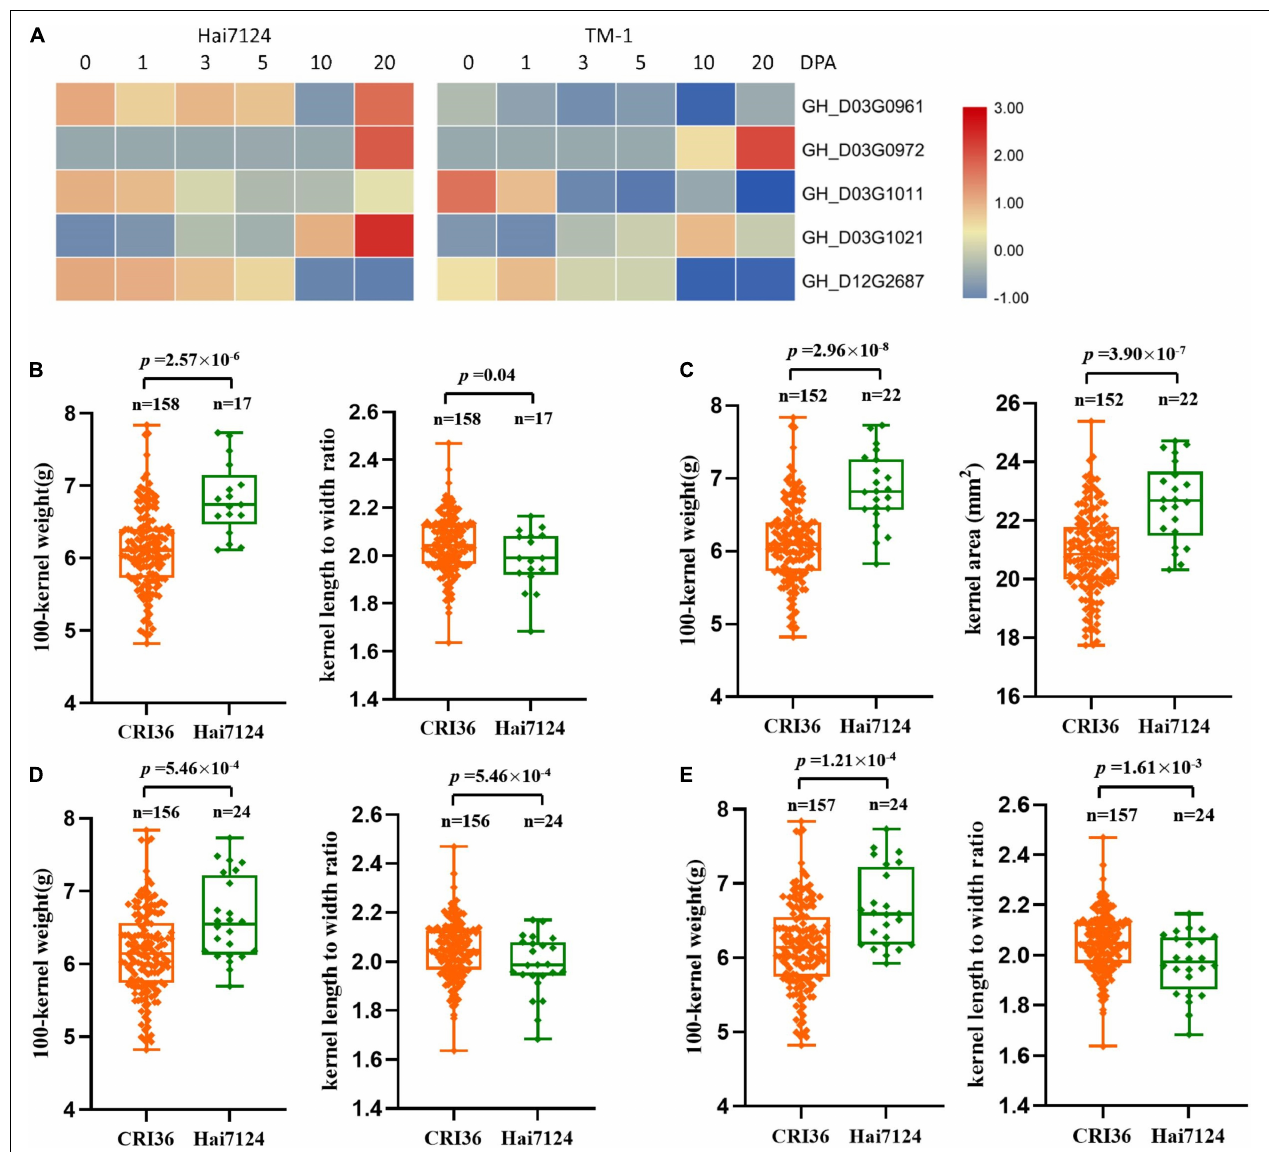
FIGURE 3 | The expression levels and genotypic evaluation of five candidate genes in ovules of each development stage (0, 1, 3, 5, 10, and 20 days post anthesis) of G. hirsutum TM-1 and G. barbadense Hai7124. (A) The expression levels of five candidate genes in ovules of each development stage (0, 1, 3, 5, 10, and 20 days post anthesis) of G. hirsutum TM-1 and G. barbadense Hai7124. (B–E) The distribution and means of seed size and shape traits in the BIL population based on SNP alleles from two parents for GH_D03G0980, GH_D03G1091, GH_D03G1458, and GH_D03G1466,